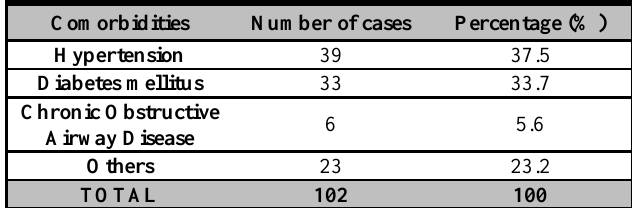
Table 2. Comorbidities associated with abdominal wall hernias